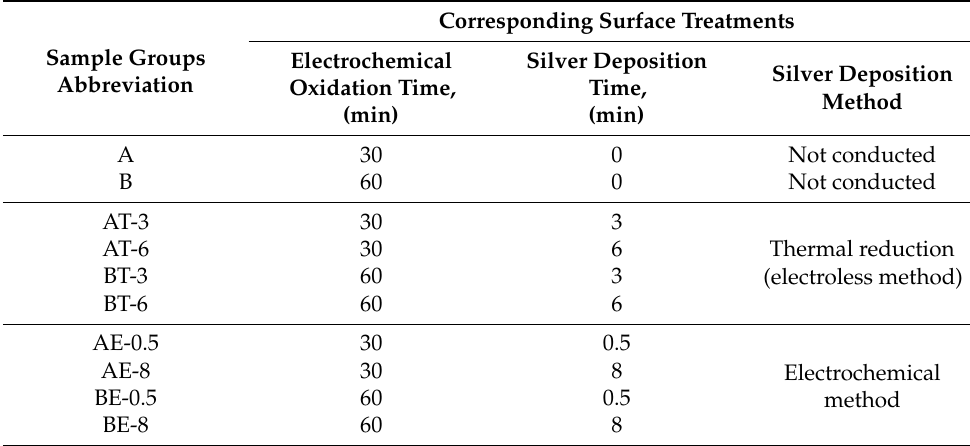
Table 1. Abbreviations of specimen groups used in the